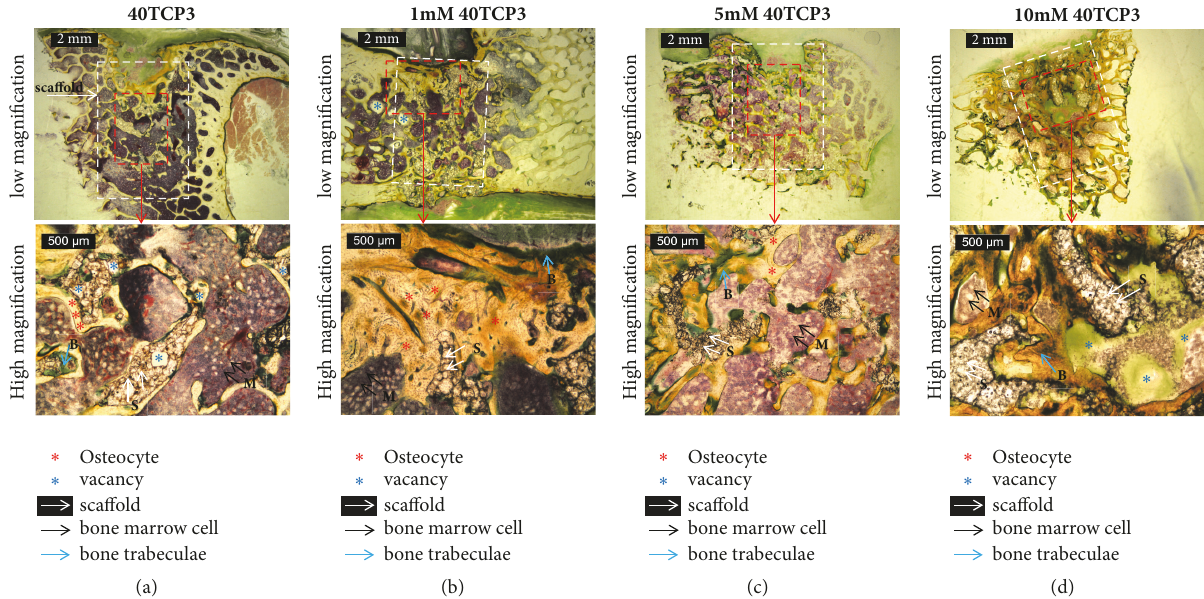
Figure 8: Histological analyses of humeral, femoral, and tibia bone by Villanueva Osteochrome bone staining at 24 weeks after implantation of each group: (a) 40 TCP 3, (b) 1mM 40 TCP 3, (c) 5mM 40 TCP 3, and (d) 10mM 40 TCP 3. The number in front of 40 TCP 3 signifies the concentration of NAC in coating solution for loading NAC on the